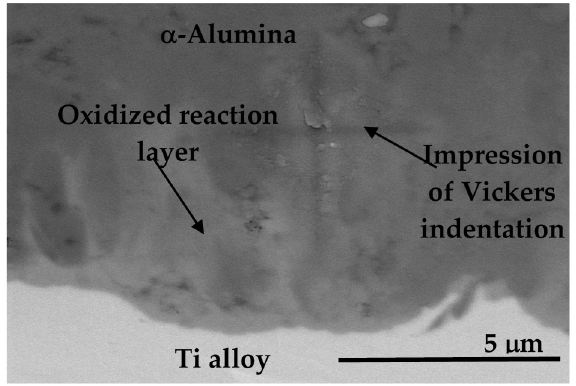
Figure 10. BSE image show sectional view of alumina layer ‐ reaction layer ‐ Ti alloy and impression of